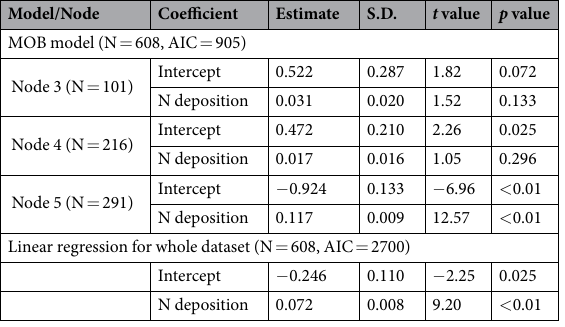
Table 3. Statistical summary of linear models in MOB (Fig. 4) and whole